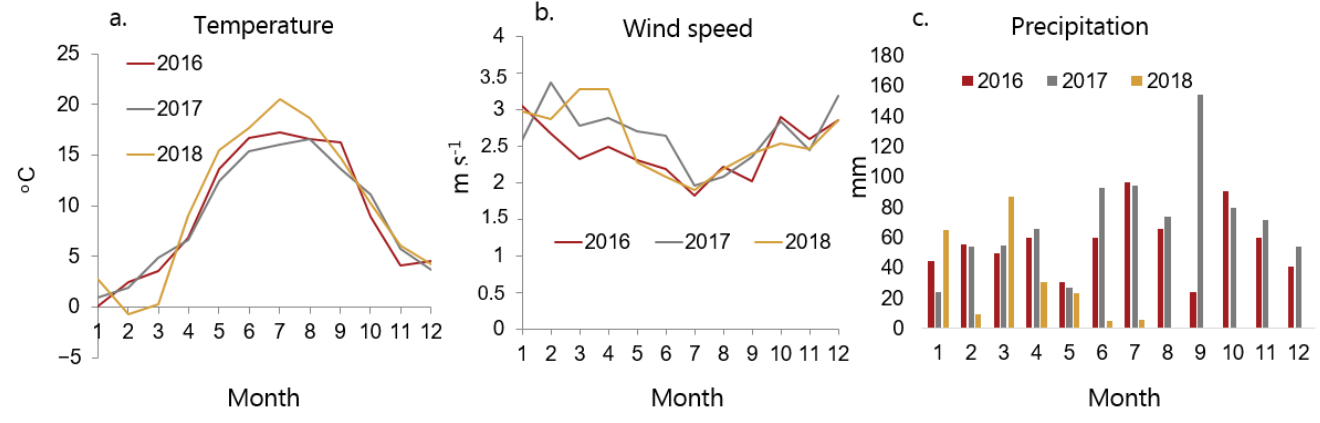
Figure 1. Seed traps placed in ( a ) wheat and ( b ) oat fields in 2018.